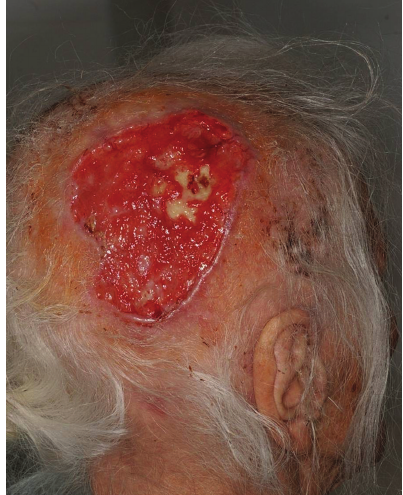
Figure 4: Case 2: An ulcerated tumor in the right parieto-occipital region, with bone